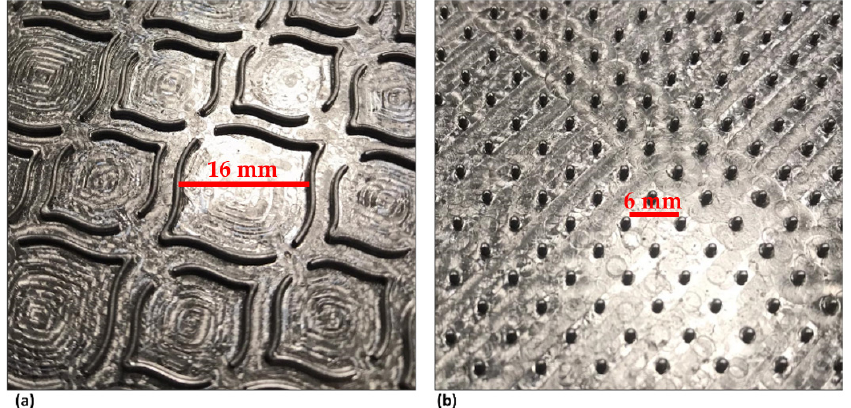
Figure 2. Photographs of steel embossing plates: ( a ) deco embossing, and ( b ) micro embossing.